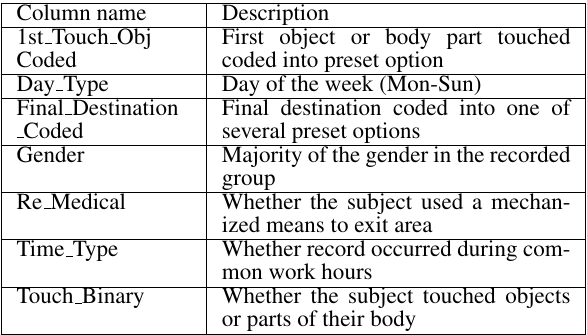
Table 1. Attributes available for data segmentation.